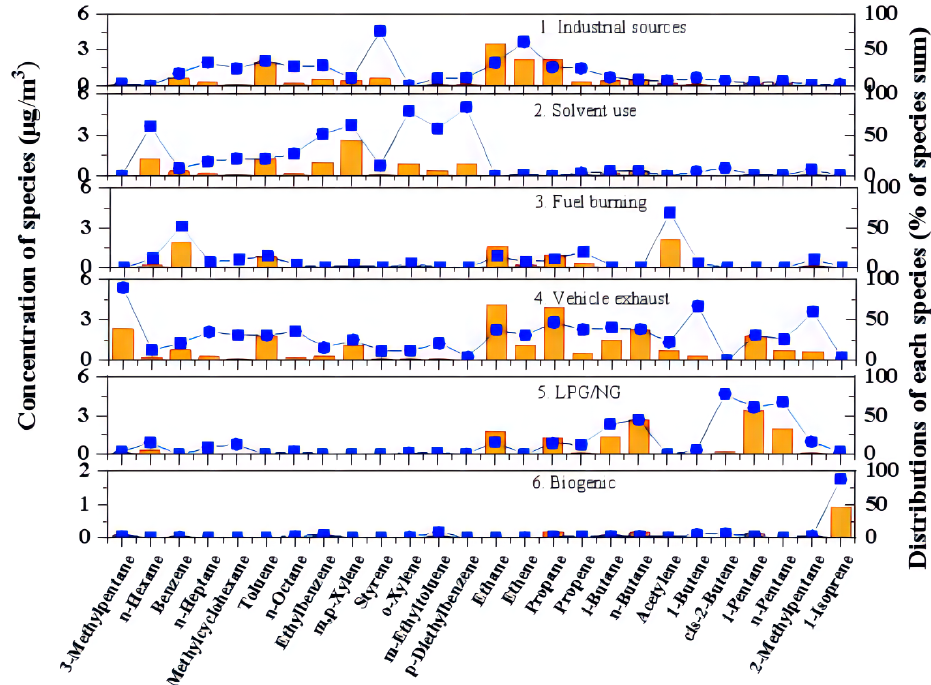
Figure 4. Source profiles and contribution percentages during the observation period by PMF model (a bar is a mixing ratio, and a dot is a